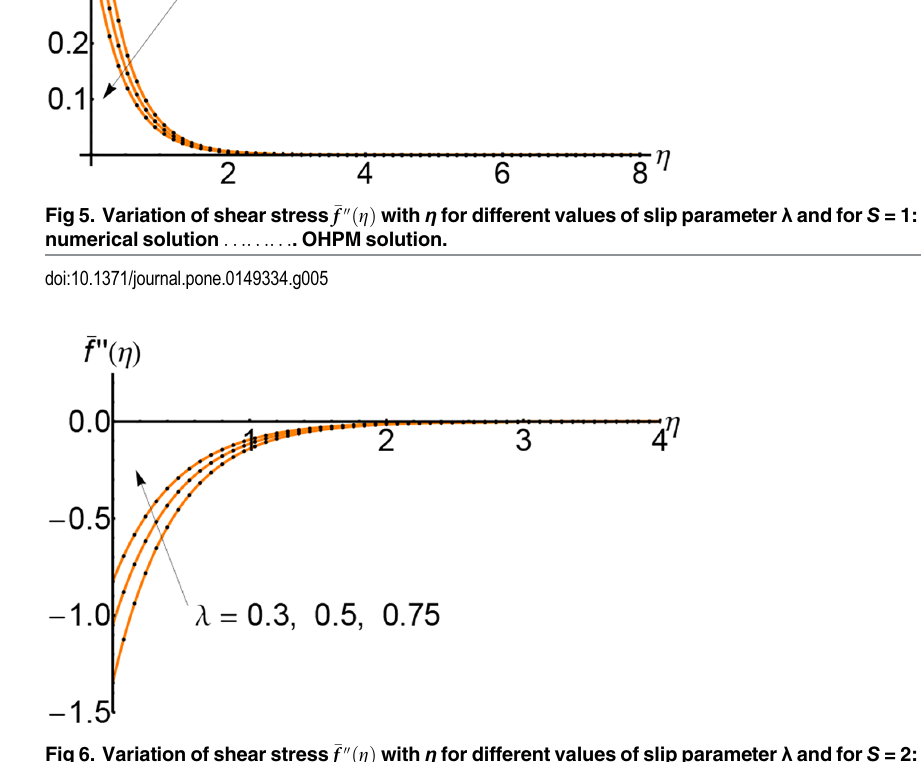
Fig 6. Variation of shear stress (cid:2) f 00 ð Z Þ with η for different values of slip parameter λ and for S = 2: —— numerical solution ......... . OHPM solution.